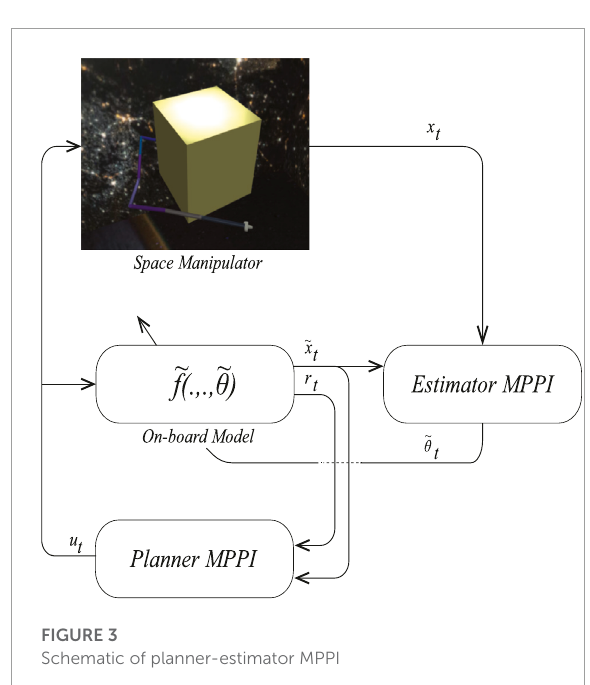
FIGURE 3 Schematic of planner-estimator